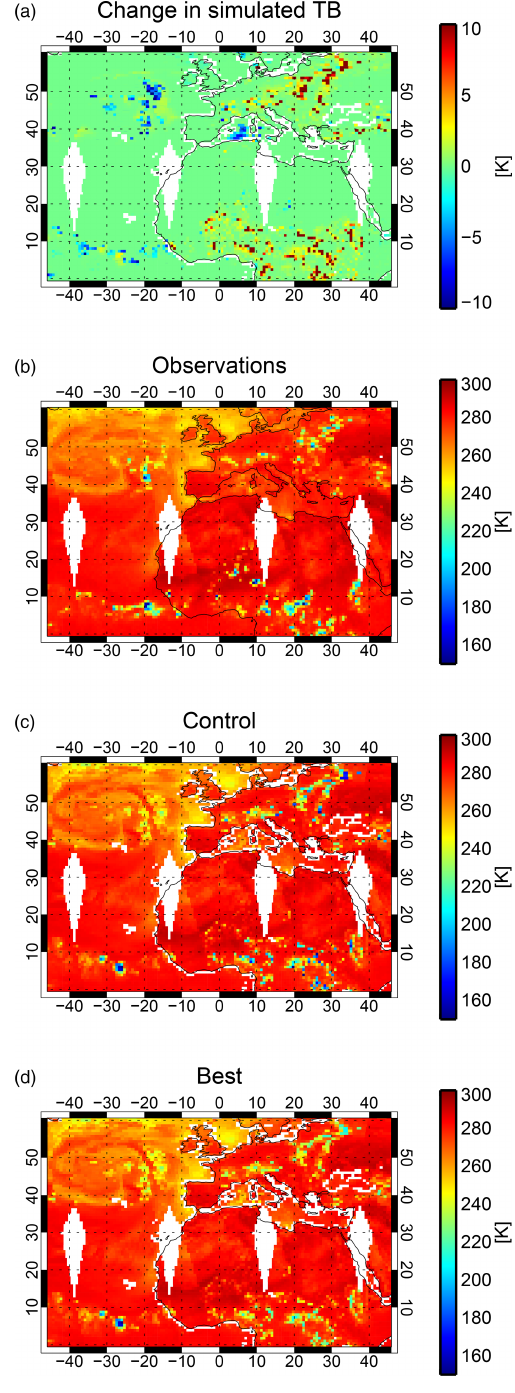
Figure 9. Example of SSMIS 150h brightness temperatures on 21 June 2019 (00:00–24:00UTC): (a) change between control and best configuration; (b) observations; (c) control simulations; (d) best configuration simulations. The colour scale in (a) is opti- mised to highlight the negative range; positive changes go off scale to as much as